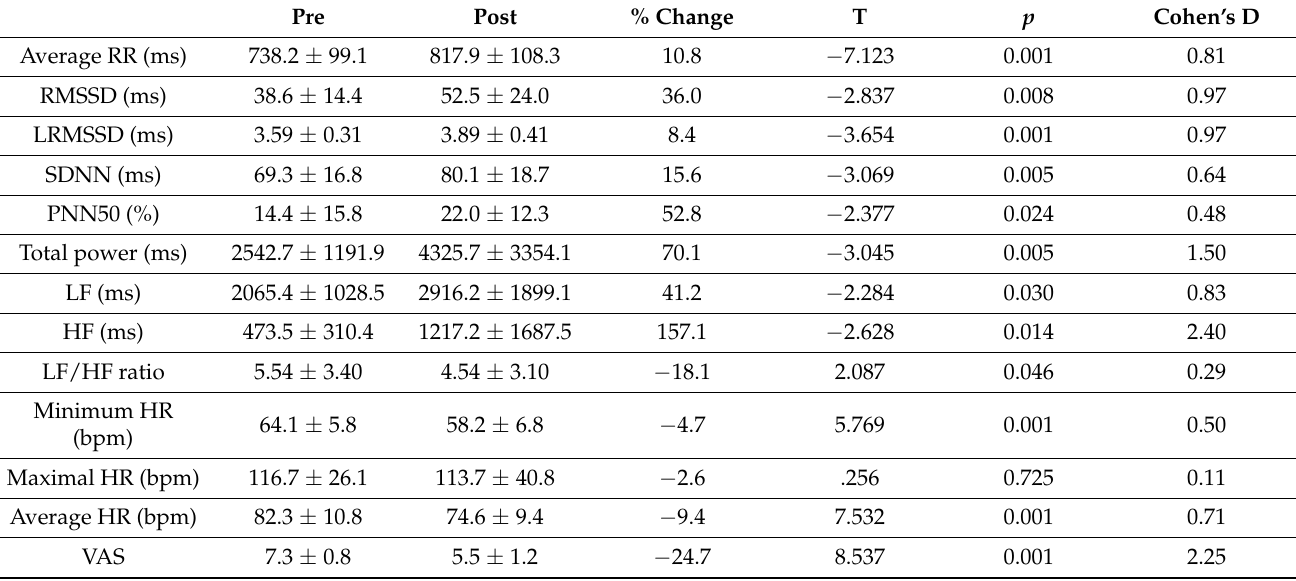
RMSSD—the square root of the mean value of the sum of squared differences of all successive R-R intervals; LRMSSD—logarithm of the square root of the mean value of the sum of squared differences of all successive R-R intervals; SDNN—standard deviation of all